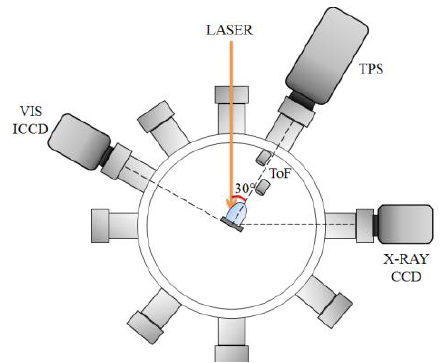
Fig. 1. Schematic view of the experimental